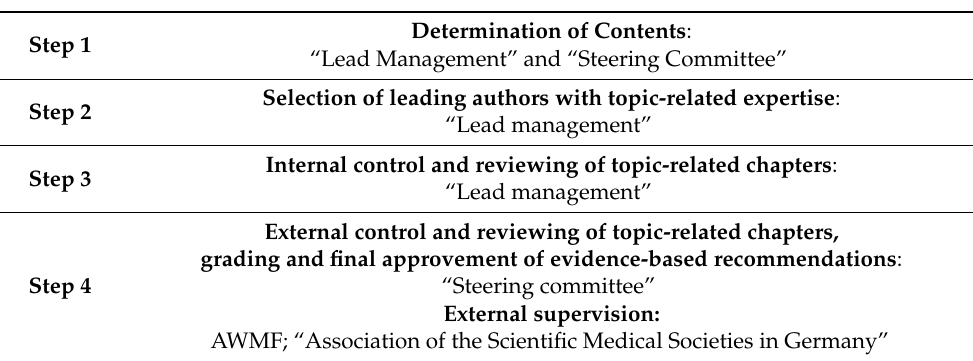
Table 1. Cardiac Rehabilitation Guidelines of German Speaking Countries in Europe (LLKardReha- DACH): Guidelines generation—major organizational